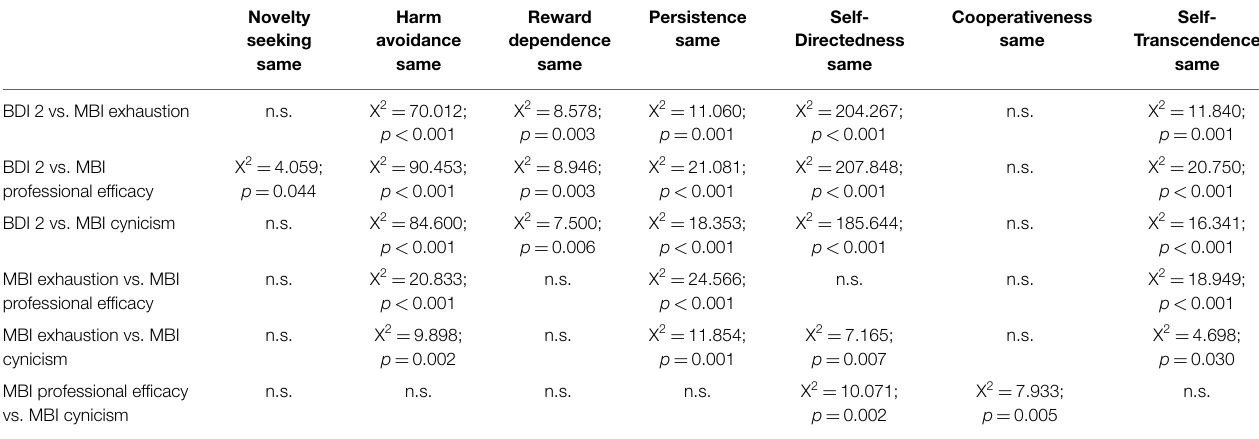
TABLE 6 | Results of the path analyses comparing MBI subscale scores with each other and with the BDI 2 (employee sample) .